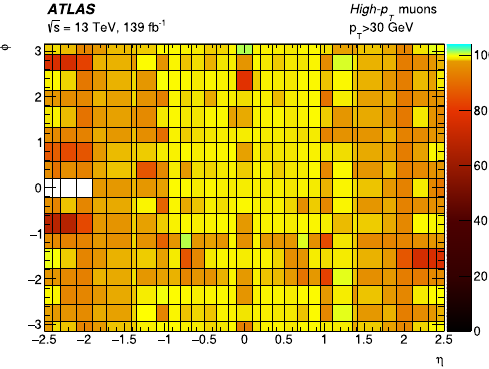
in Z → μμ events. The white area in the η < − 2 . 0 and φ (cid:8) 0 region corresponds to a vetoed problematic CSC